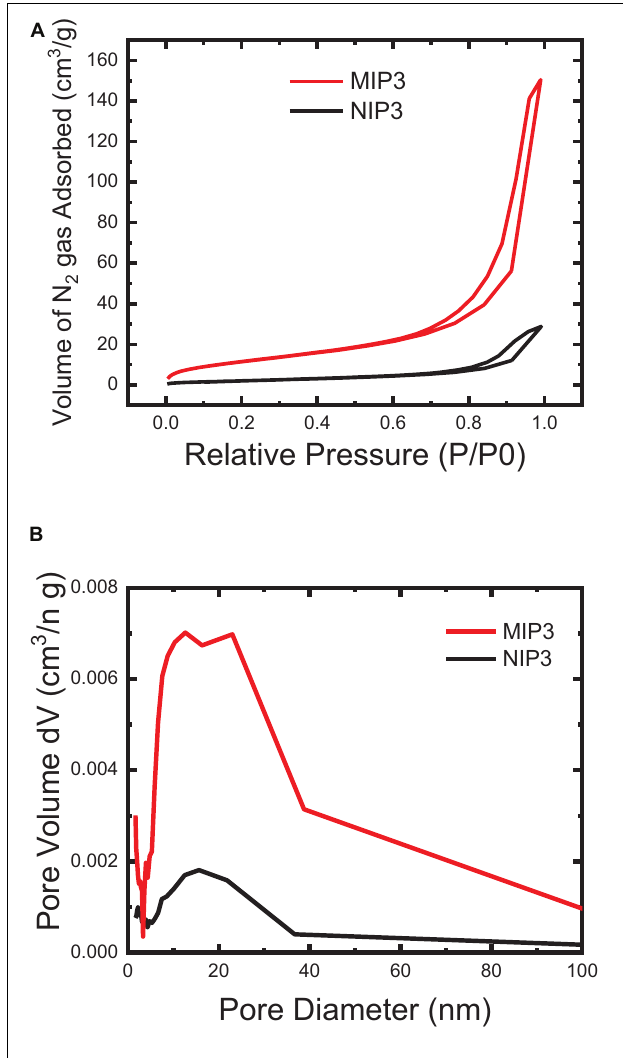
FIGURE 6 | BET surface area of the MIP and NIP powder particles: (A) N 2 Adsorption-desorption (BET isotherm) and (B) BJH pore size distribution.